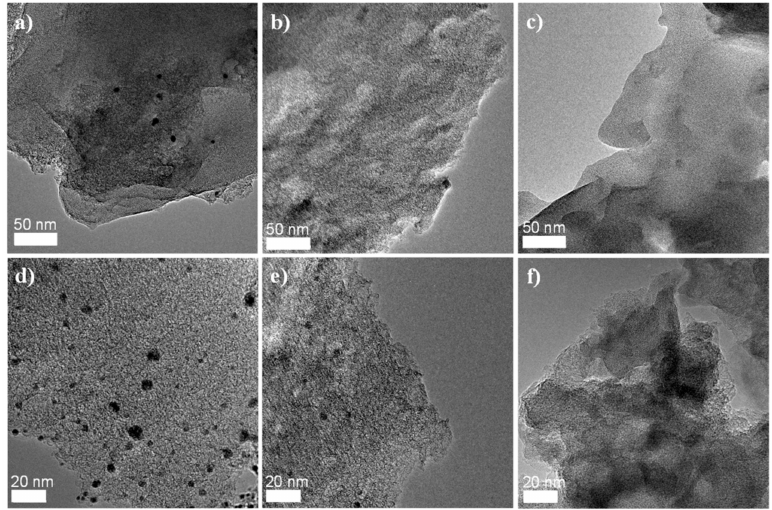
Figure 2. HAADF-STEM images of fresh ( a ) Pd / AC ( b ) Pd-IL / AC ( c ) Pd-2A-IL / AC and used ( d ) Pd / AC ( e ) Pd-IL / AC ( f ) Pd-2A-IL / AC